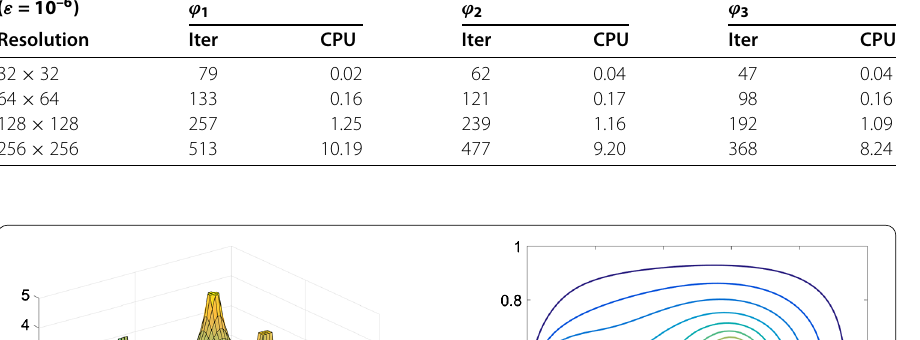
Only the apparent difference is the CPU time; an iteration of the nonlinear solver is about as six time expensive as that of the linear solver, due to the computation of coefficients as in (.). For ϕ = ϕ  , the nonlinear solution is plotted in Figure . Compared with the linear solutions in Figure , the nonlinear solution shows slightly lower function values, which is expected. As the grid point approaches the obstacles, the solution shows an increasing gradient magnitude. This may enlarge weights for far-away grid values as shown in (.), which in return acts as a force to reduce function values. The difference between the linear solution and the nonlinear solution, at the  ×  resolution, is depicted in Figure